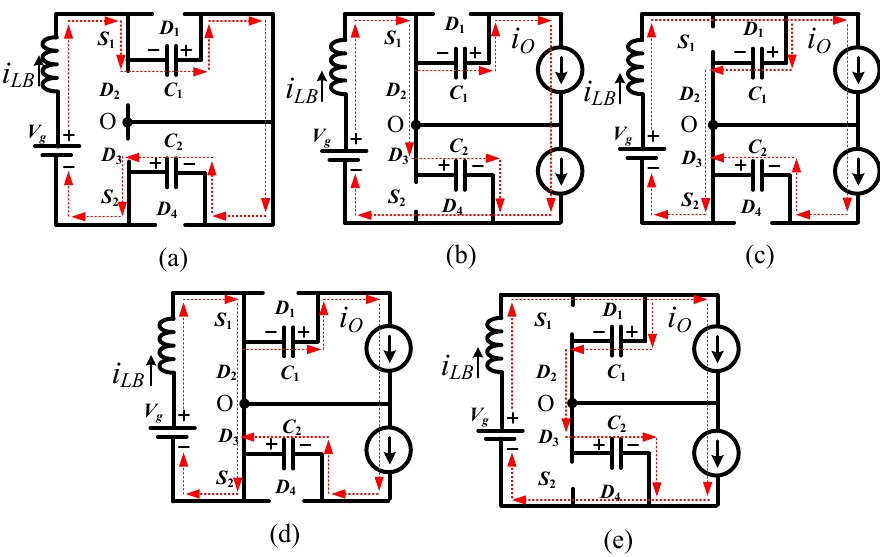
Figure 3. The modes of 3L-qSBT 2 I: ( a ) ST mode, ( b ) NST mode 1, ( c ) NST mode 2, ( d ) NST mode 3, and ( e ) NST mode 4. Table 1. On/Off states of 3L-qSBT 2 I switches and diodes ( X = A , B , C